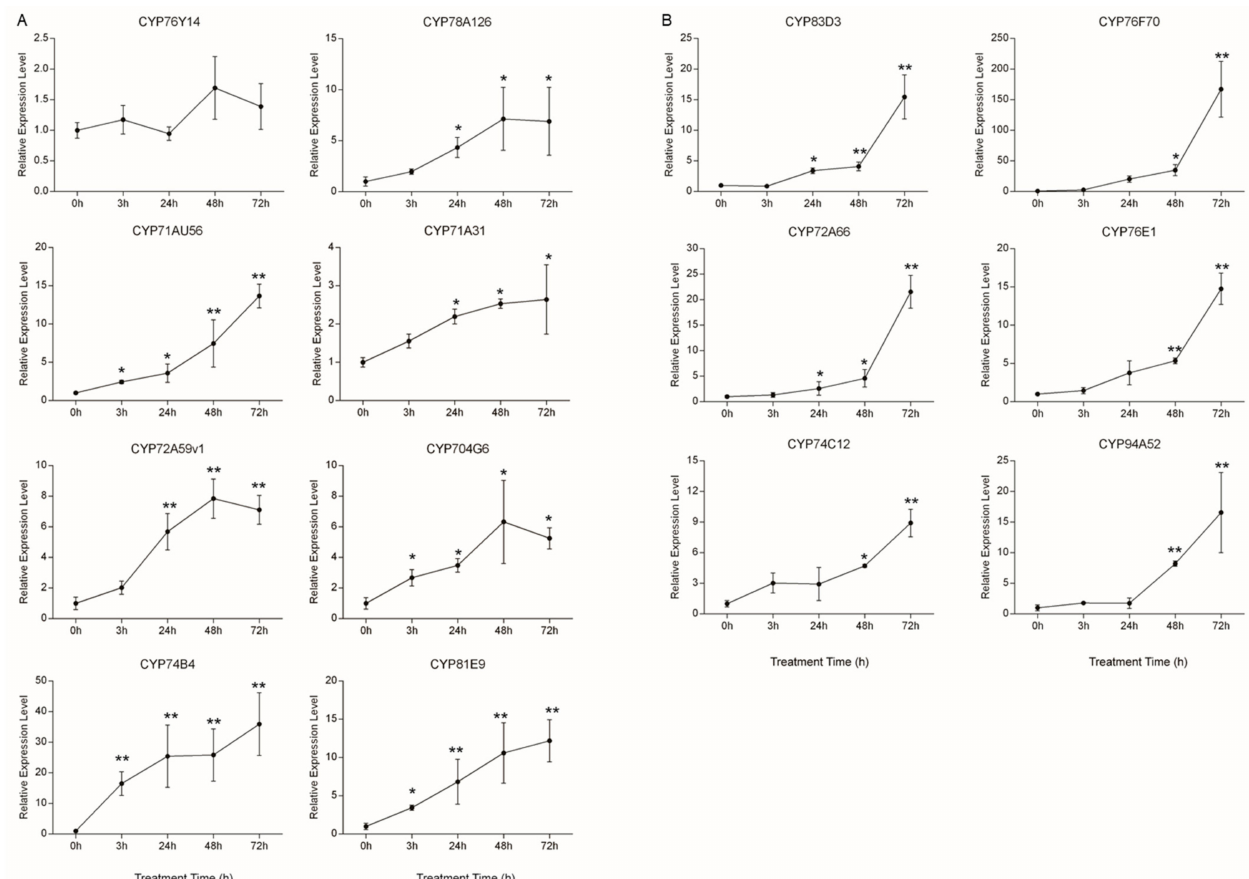
Figure 8. Analysis of the 14 hub genes under drought/salt treatments by qPCR. ( A ) Relative expression levels of eight hub MtP450 genes under drought treatment at 3h, 24h, 48 h and 72 h, with that of 0h as control (set as value of 1). ( B ) Relative expression levels of six hub MtP450 genes under salt treatment at 3 h, 24 h, 48 h and 72 h, with that of 0h as control (set as value of 1). The differential expression analysis was conducted based on the 2 − ∆∆ ct method. Data are from three biological replicates and three technical replicates. * p < 0.05, ** p <